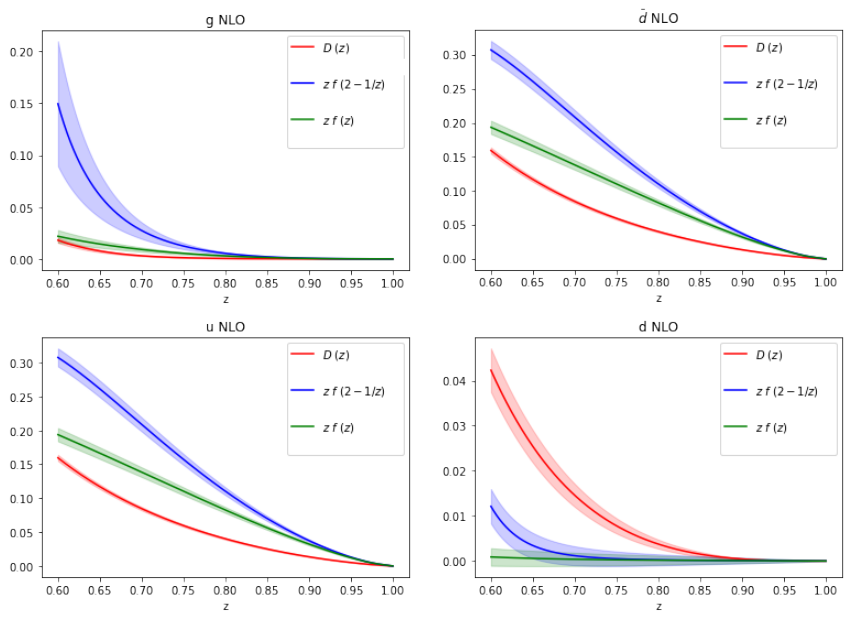
Figure 5. Fragmentation functions and parton distribution function from the same set [13] used to test the Barone-Drago-Ma